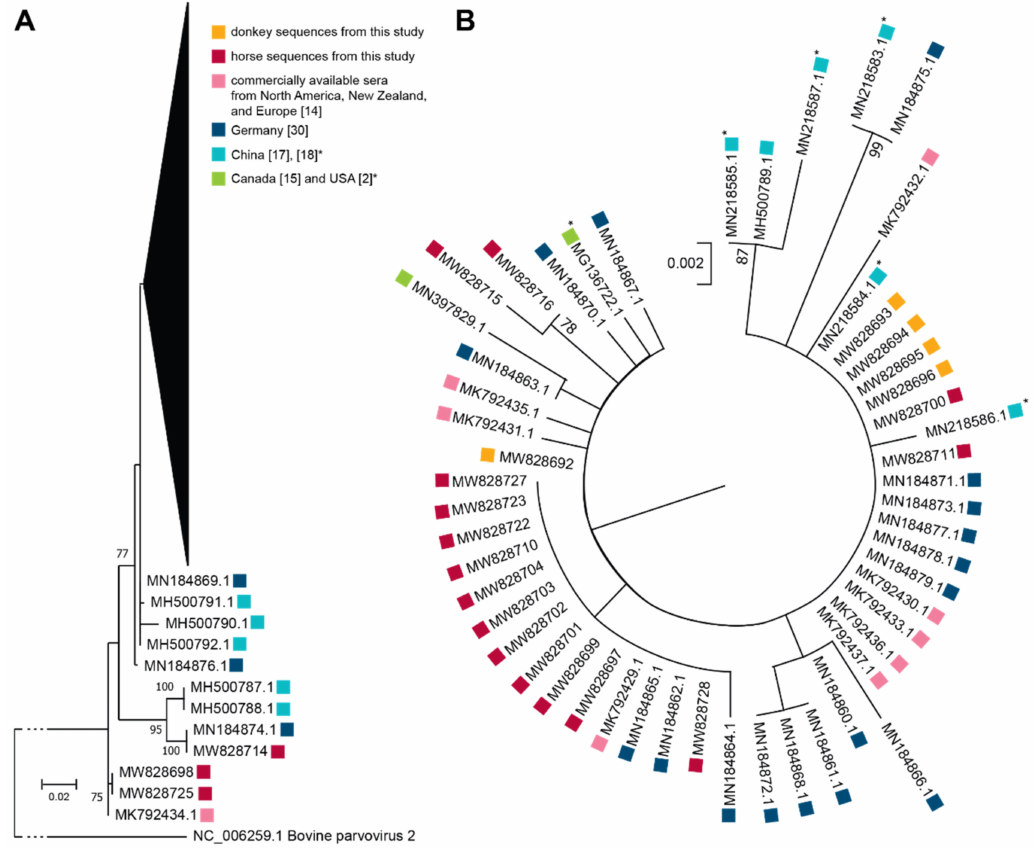
Figure 6. Molecular Phylogenetic analysis by Maximum Likelihood method. Maximum likelihood phylogenetic trees are drawn to scale with branch lengths measured in the number of substitutions per site. All positions containing gaps and missing data were eliminated. Evolutionary analyses were conducted in MEGA X [26] Bootstrap values >70% are shown. Red squares = sequences obtained in this study, rose squares = sequences obtained from commercially available serum pools [14], dark blue squares = sequences obtained from subclinical horses in Germany [30], bright blue squares = sequences from China [17] (with asterisks [18]), yellow squares = sequences obtained from horses in North America (Canada [15] (without asterisk) and USA [2] (with asterisk)). ( A ) The analysis involved 66 nucleotide sequences with 456 positions in the final dataset. We included the bovine parvovirus 2 reference strain as outgroup. ( B ) Sequences that belong to the collapsed part of the phylogenetic tree in A were reanalyzed including MN184869.1 as outgroup. The analysis involved 54 nucleotide sequences with 462 positions in the final